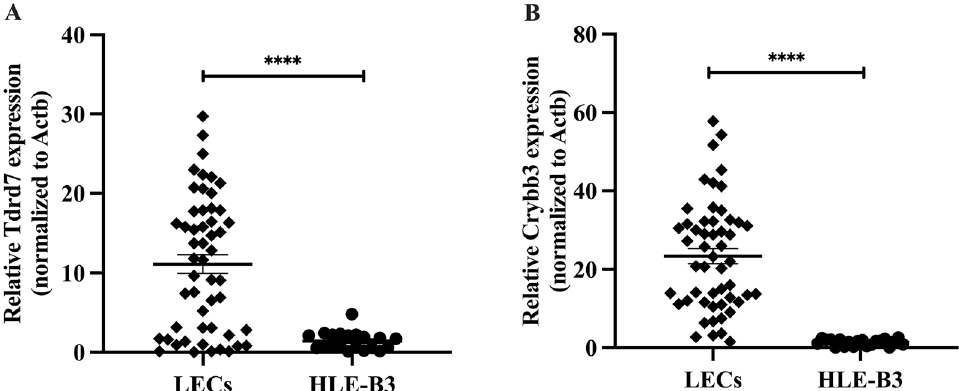
Fig. 3 Expression levels of TDRD7 and CRYBB3 in lens capsule samples in comparison to those in HLE-B3 cells. **** P < 0.001. LECs Lens Epithelial Cells, HLE-B3 Human Lens Epithelial Cell